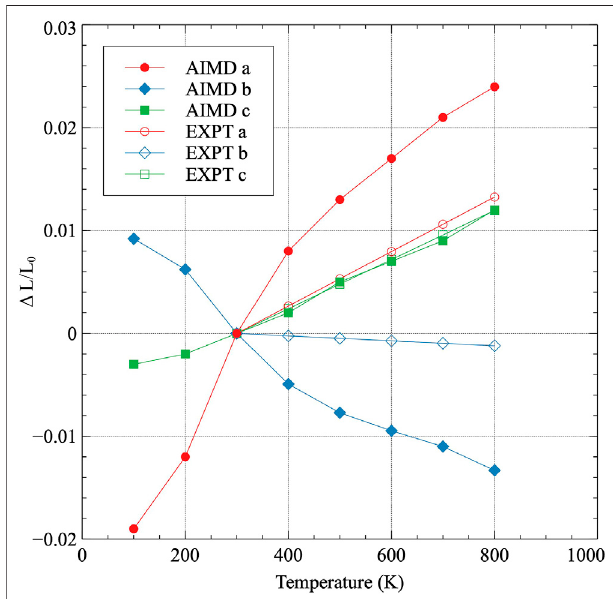
FIGURE 3 | The linear thermal expansion coef fi cient for each lattice constant in α -U. Thermal expansion is normalized to 300 K, which is the lowest temperature in the experimental data Touloukian et al. (1975).